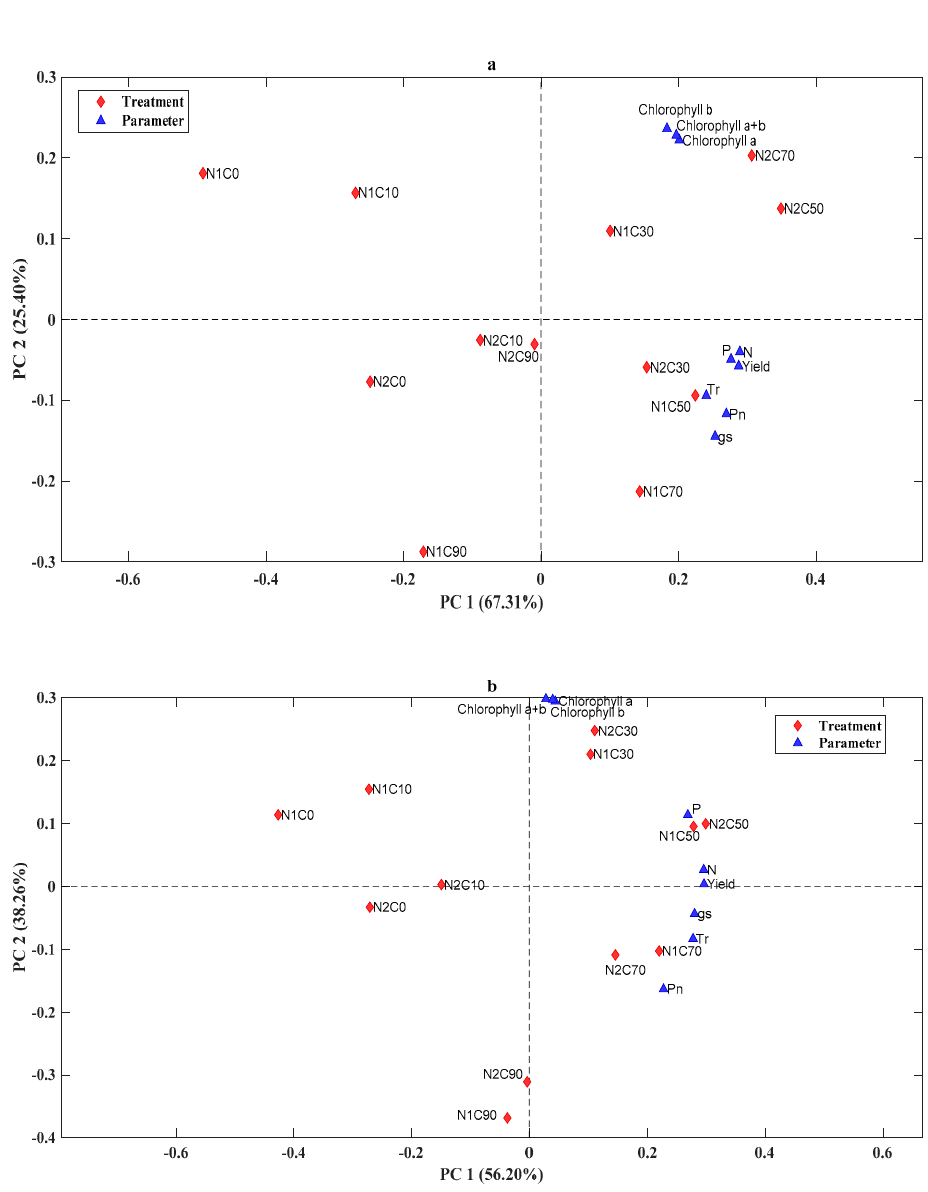
Figure 5. Principal component analyses of the nutrient uptake, photosynthetic pigments, gas exchange parameters and tomato yield in response to biochar and N application in 2017 ( a ) and 2018 ( b ).